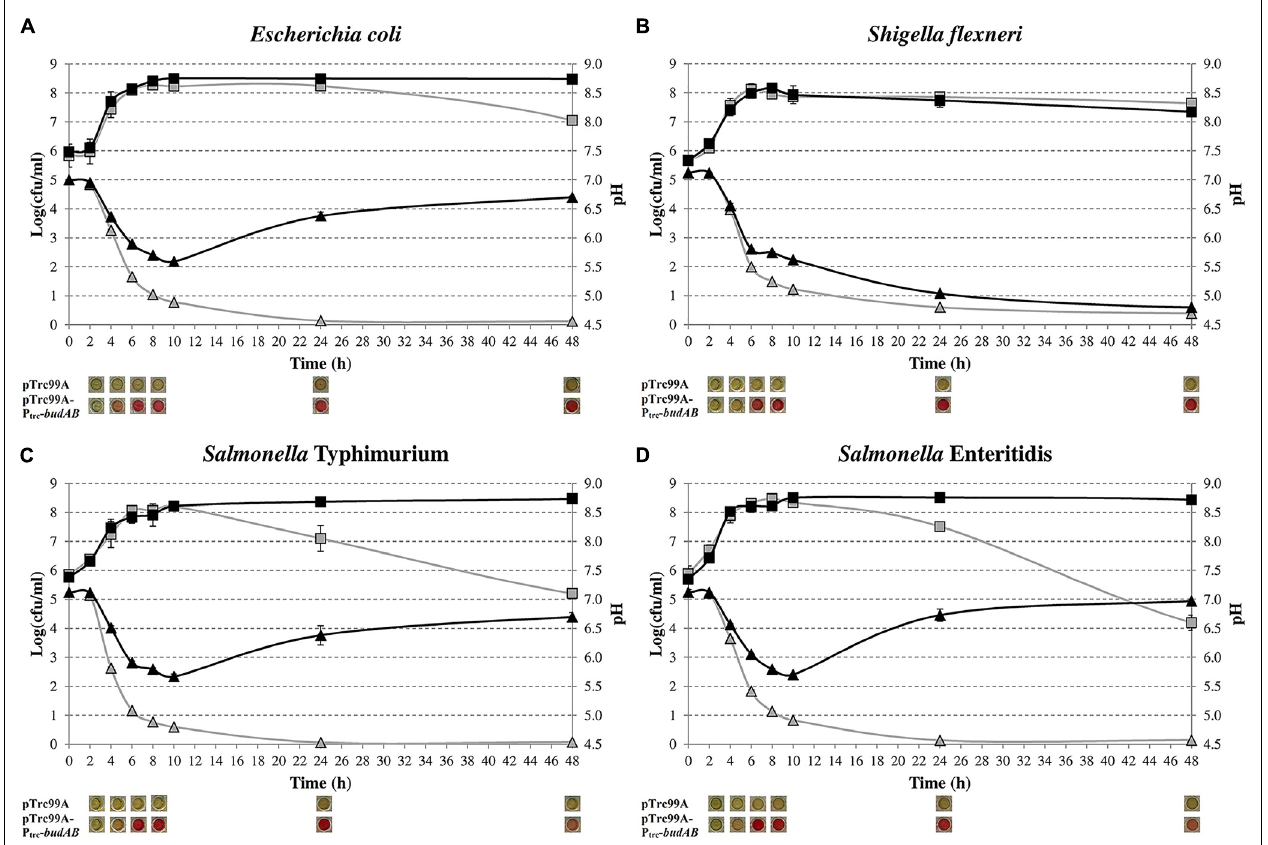
FIGURE 1 | Growth of Escherichia coli MG1655 (A), S. flexneri ATCC 12022 (B), S. Typhimurium LT2 (C) and S. EnteritidisATCC 13076 (D) in LB medium containing 5 g/l glucose, 1 mM IPTG and 100 μ g/ml ampicillin (Ap), in sealed microtiter plates incubated at 37 ◦ C for 48 h. Cell numbers